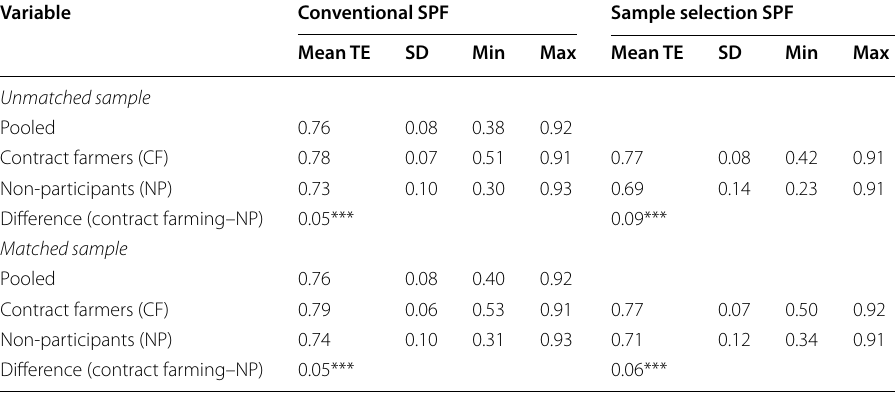
***, **, and * denote significance at 1%, 5%, and 10% levels, respectively